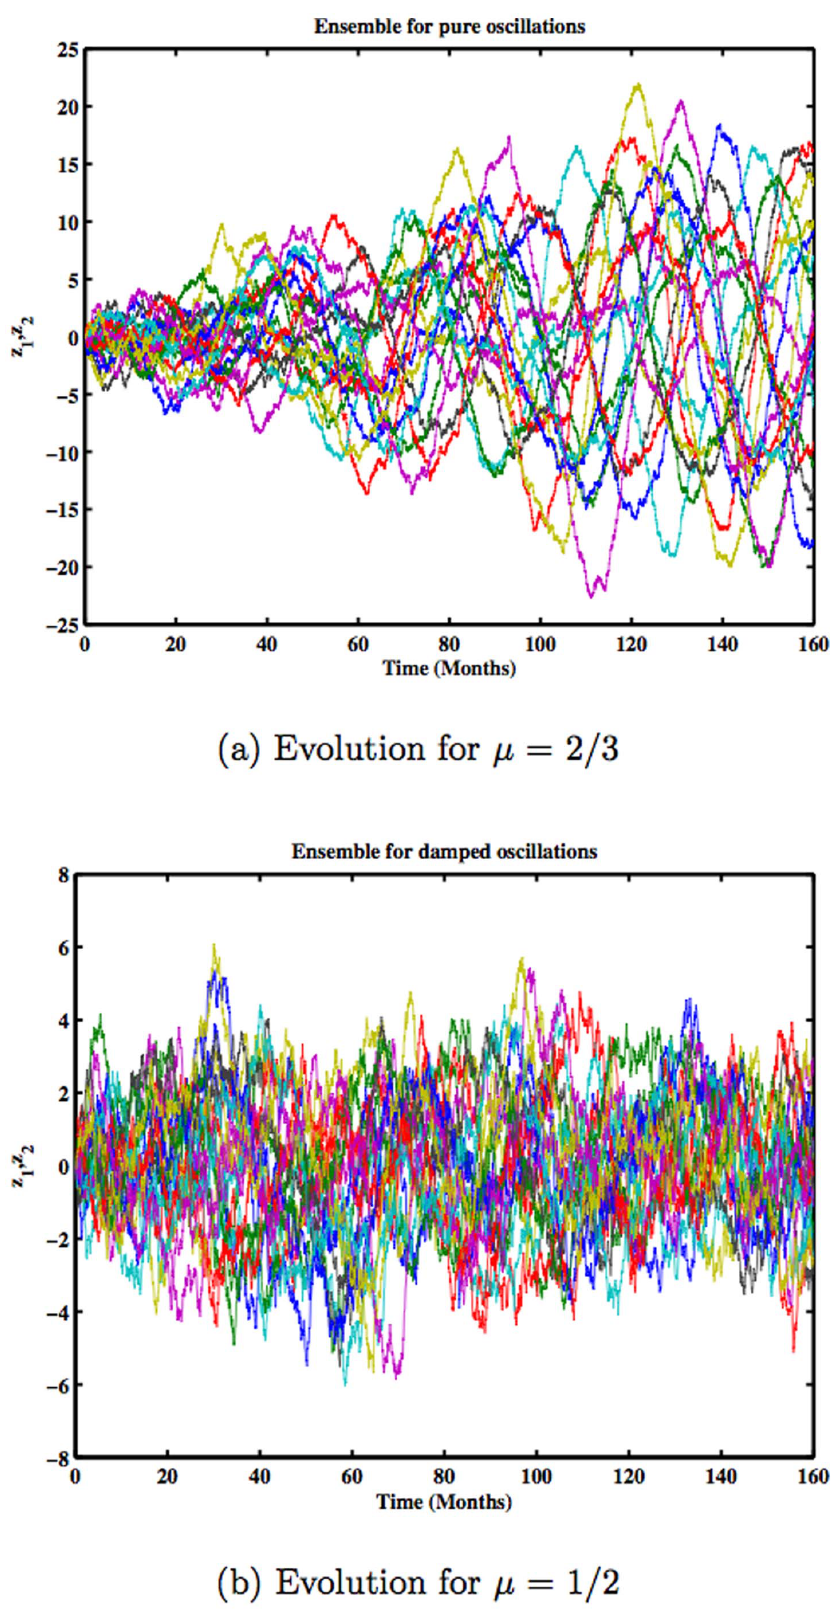
Figure 3. The time evolution of 10 members for the critical case m ~ 2 = 3 (a) and the subcritical case m ~ 1 = 2 (b).